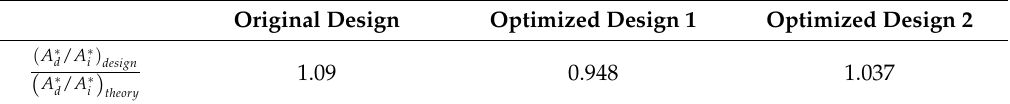
Table 4. Ratio of design A d * / A i * to theoretical A d * / A i * .